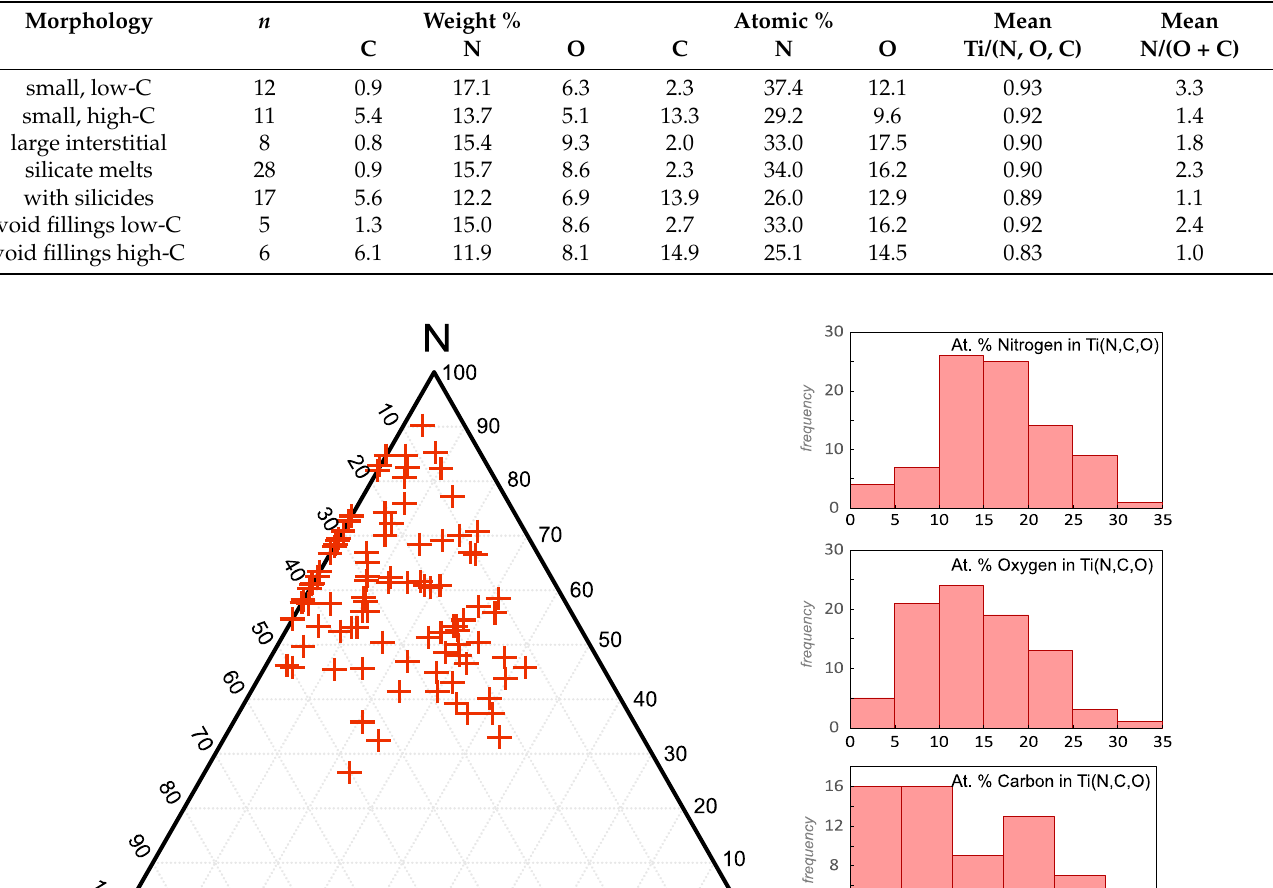
Table 1. Summary of populations.